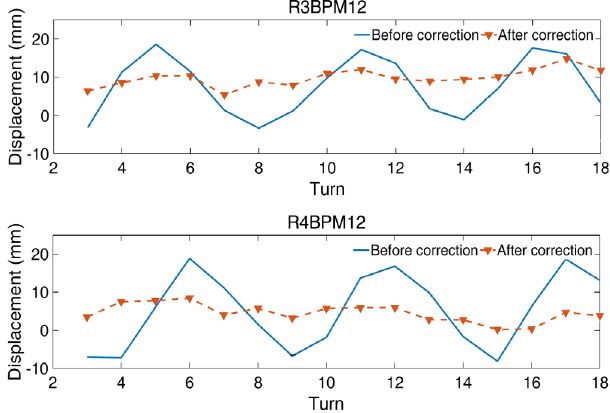
FIG. 10. Similar to Fig. 5 but with the BPM resolution set to 3.5